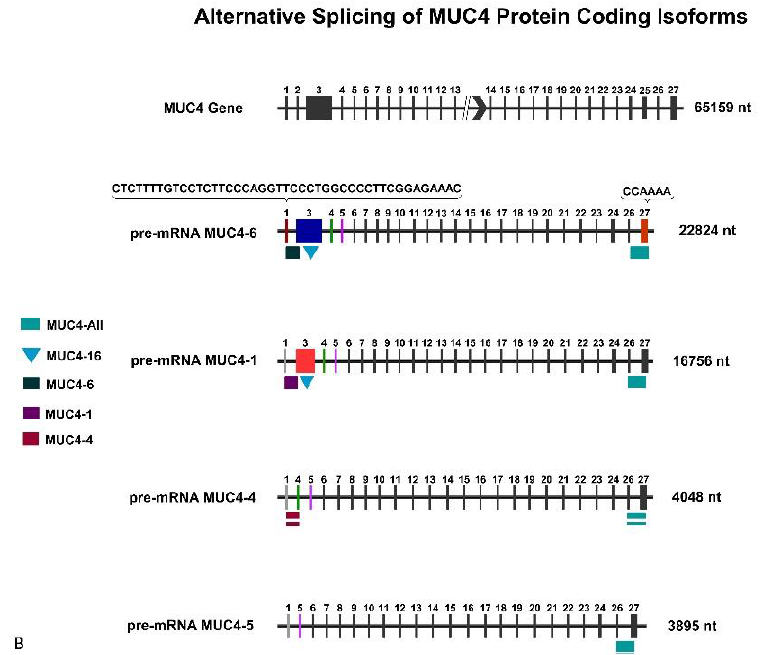
Figure 3. Sequence similarity analyses for ADAM12. ( A ): Sequence similarity of the five alterna- tively spliced isoforms of ADAM12 . ( B ): Illustration of the exon organization of ADAM12 used to design primers for the specific amplification of alternatively spliced isoforms. The ADAM12 gene and isoforms are presented as horizontal lines. Each vertical bar represents an exon separated by intronic regions. The image shows the skipping of exon 14 in all isoforms and the pretermination of isoforms 2, 4 and 5.